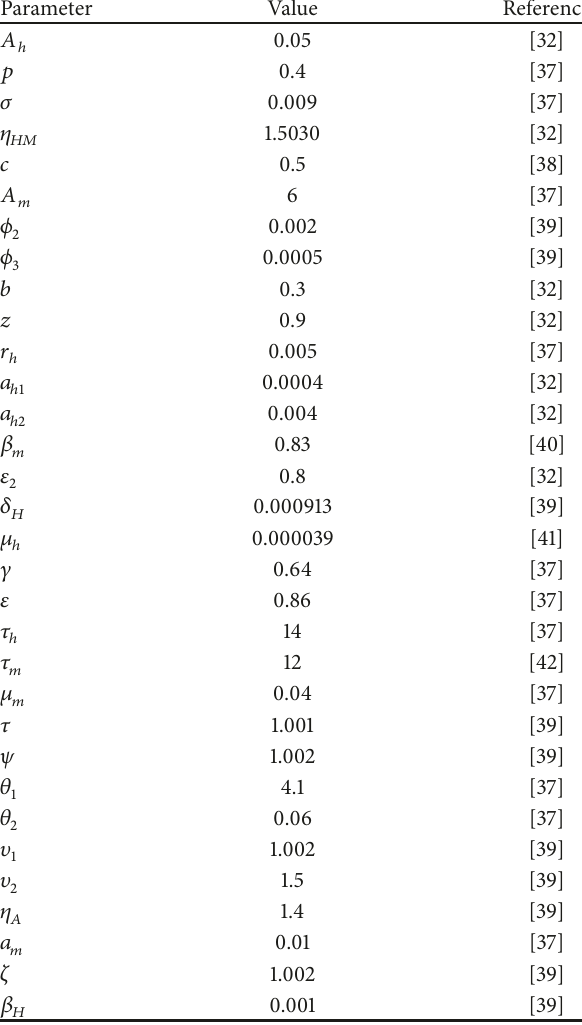
Table 1: The values of parameters used in the numerical results.